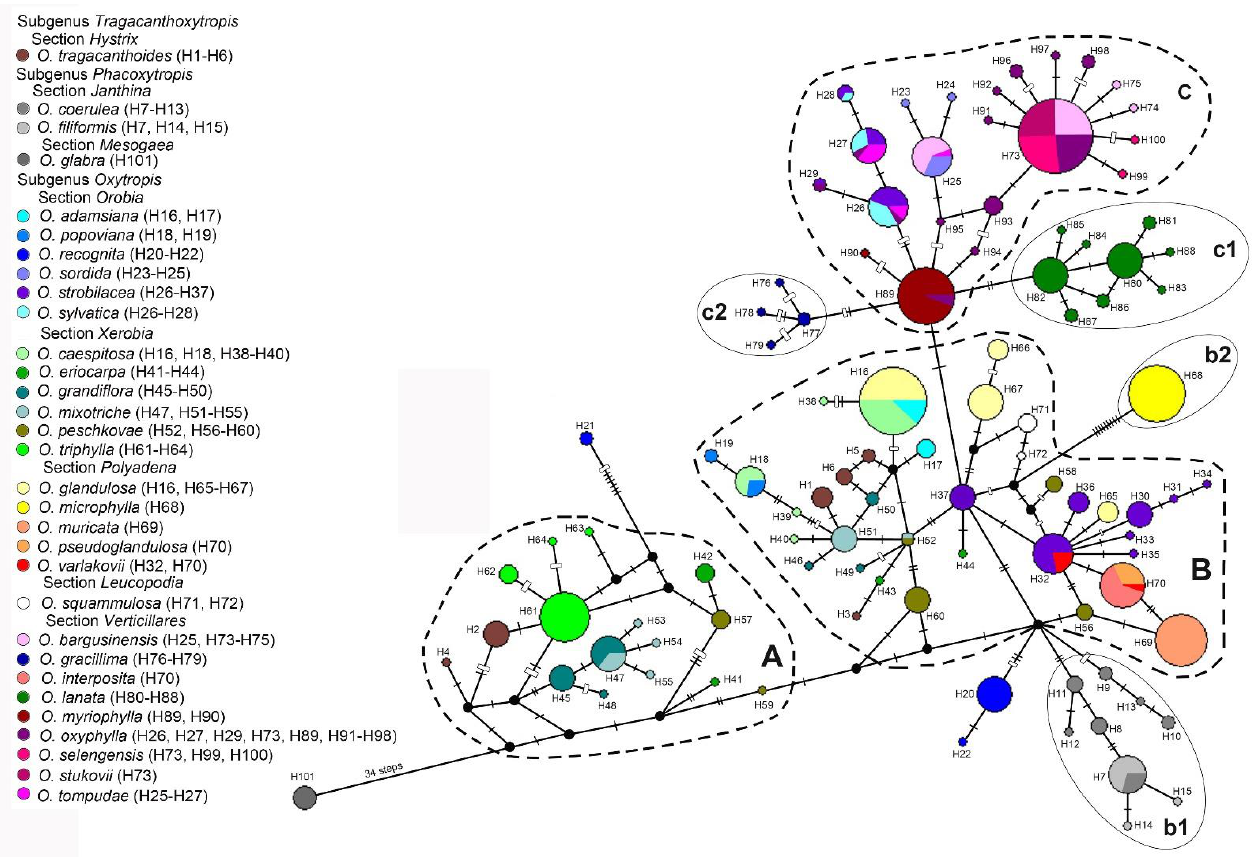
Figure 3. Median-joining network inferred from combined sequences of the psbA-trnH , trnL-trnF , and trnS-trnG regions showing the relationships among cpDNA haplotypes (H1–H101) of 31 Oxytropis species from Southern Siberia. Each circle represents the haplotype; the size of the circles reflects the frequency of occurrence of haplotype. The colors of circles indicate the affiliation of haplotype to certain species. Black small circles indicate the median vectors; thin bars indicate the mutational events; white thick bars indicate the indels; dashed lines are circled haplogroups A, B, C; thin lines are circled separate branches b1, b2, c1, and c2.